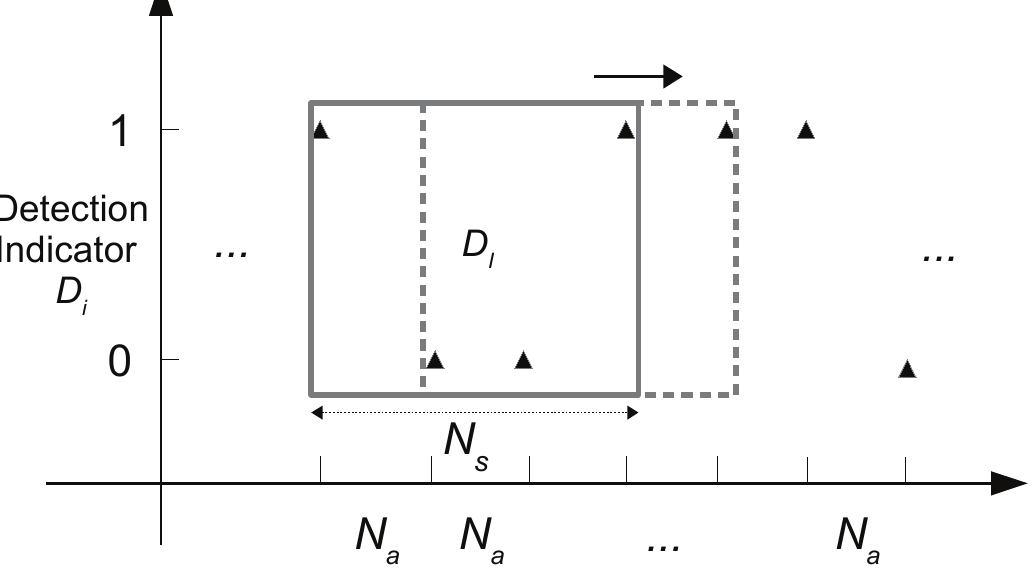
Figure 2. The sliding detection window with detection activated every N a sampling steps, where triangles represent the detection indicator D i and the box with length N s represents the sliding detection